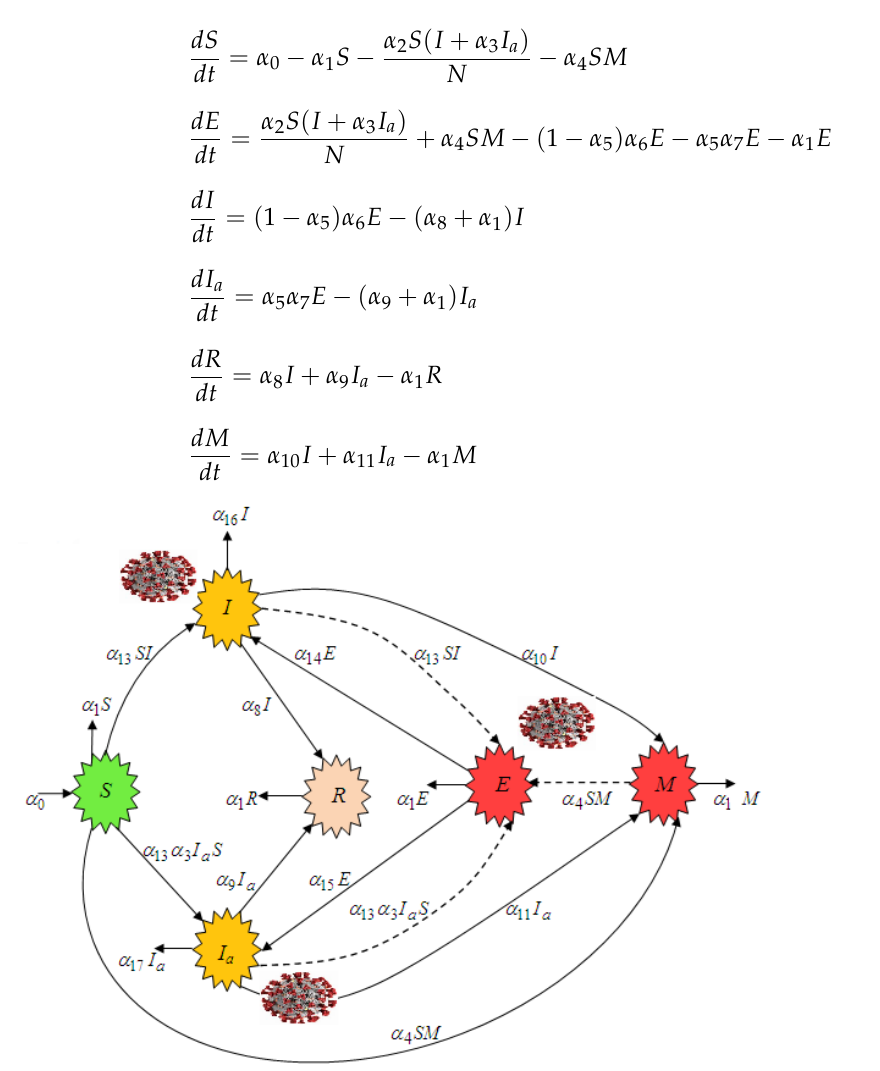
Figure 1. The compartmental diagram for COVID-19 epidemic